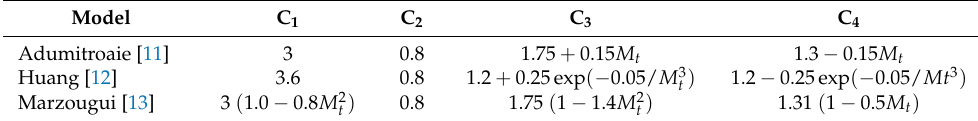
Table 1. Numerical coefficients of the pressure-strain